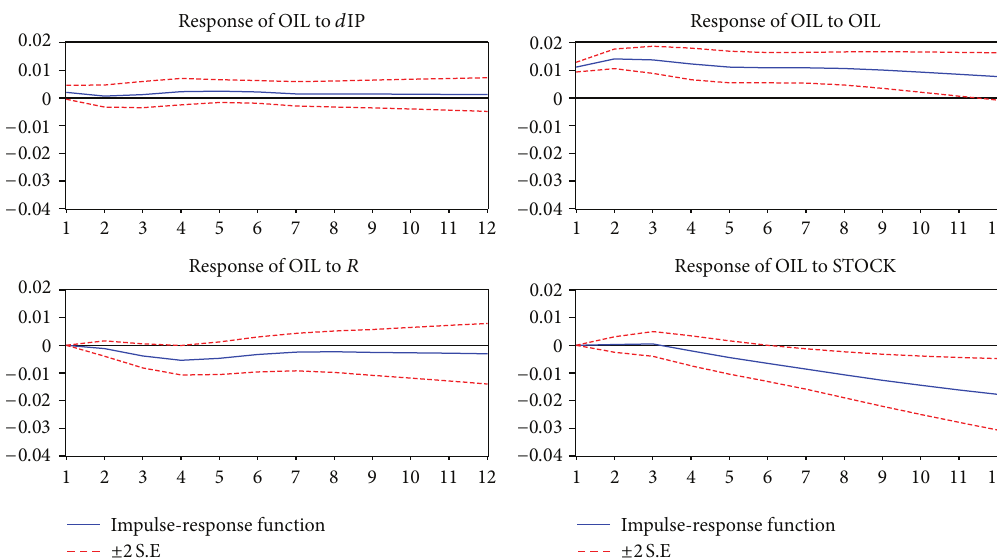
Response to cholesky one S.D. innovations